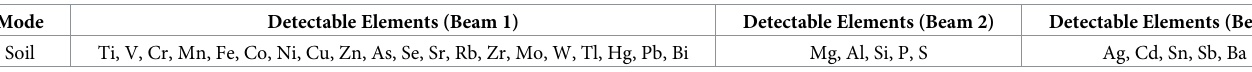
Table 1. Standard element package in Geo-Env Soil Mode of SciAps